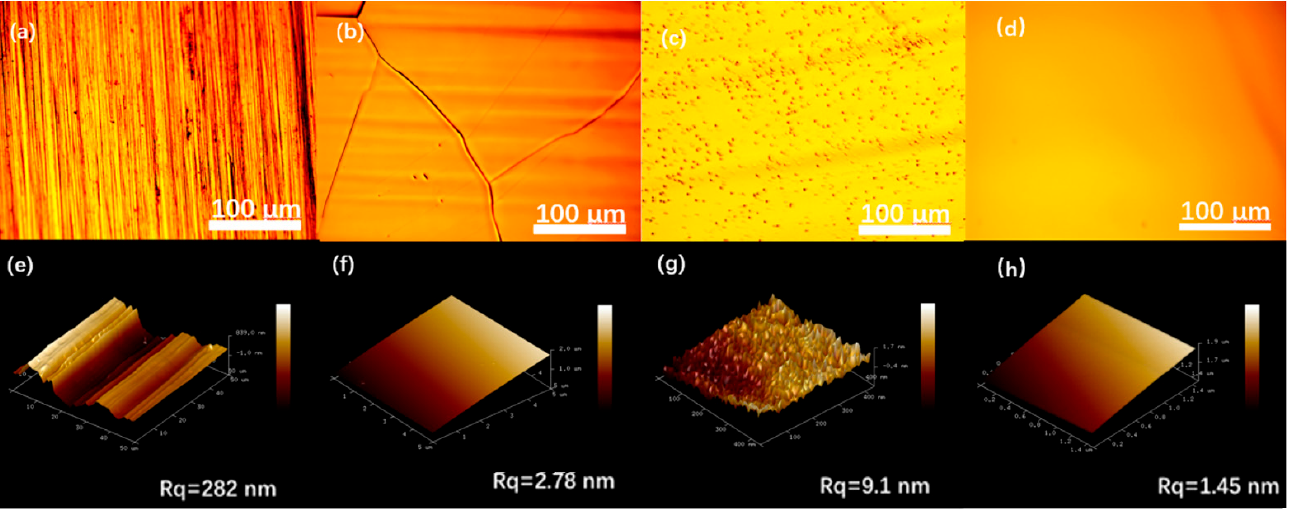
Figure 1. Optical microscopy images of ( a ) untreated substrate, ( b ) cleaned and polished annealed substrate, ( c ) nickel-plated substrate, and ( d ) re-annealing to synthesize copper-nickel alloys. 3D atomic force microscopy height images of ( e ) untreated substrate, ( f ) cleaned and polished annealed substrate, ( g ) nickel-plated substrate, and ( h ) re-annealing to synthesize copper-nickel alloys. Table 1. The surface roughness of substrates under different treatments. Cleaned and Re-Annealing to Nickel-Plated Untreated Substrate Polished Annealed Synthesize Copper- Substrate Substrate Nickel Alloys Surface 282 nm roughness